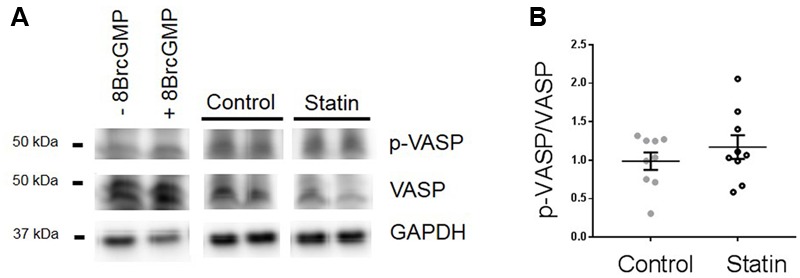
Effect of simvastatin on Ser239-phosphorylated VASP, an index of PKG activity. (A) Representative immunoblots showing Ser239-phosphorylated VASP and VASP expression in rat ventricular myocytes ± 8-Bromo cGMP (200 μM for 15 min, as a positive control for PKG activity) and myocardial homogenates from control and statin-treated animals. (B) Ratio of p-VASP to VASP. Plot shows mean ± SEM of N = 9 animals per group.